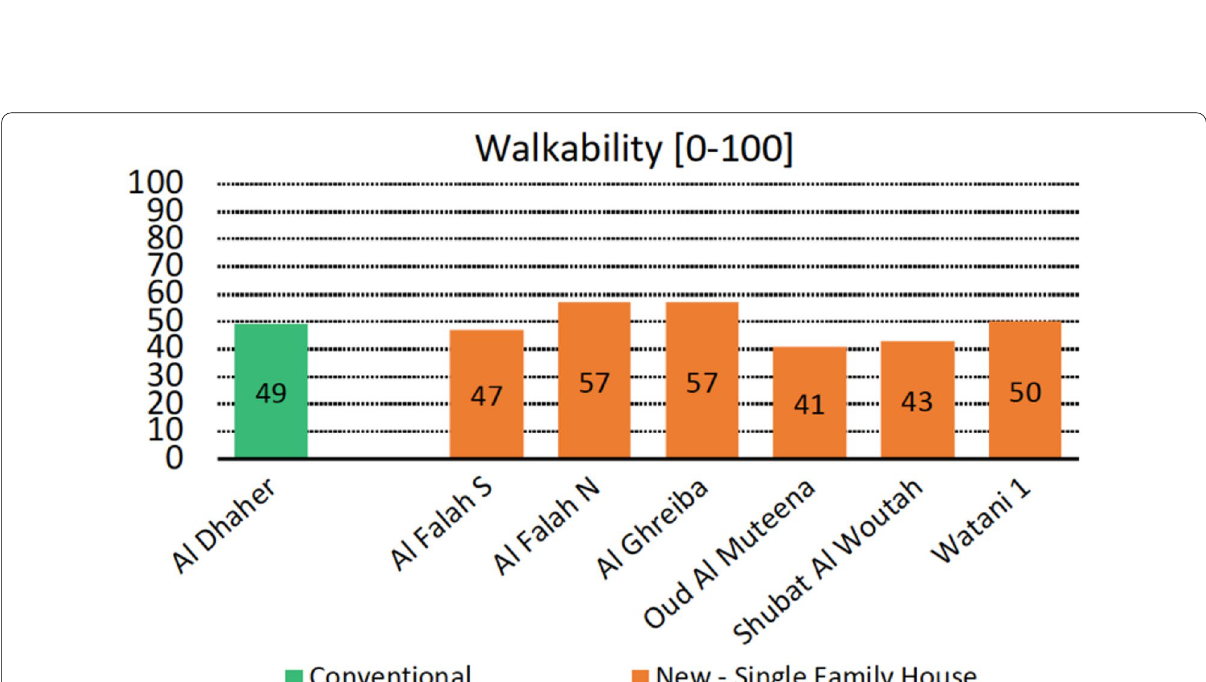
Fig. 6 Comparing UMI Walkscores for the conventionally designed urban sprawling neighborhood-Al Dhaher (N1) vs the six denser and more compact case